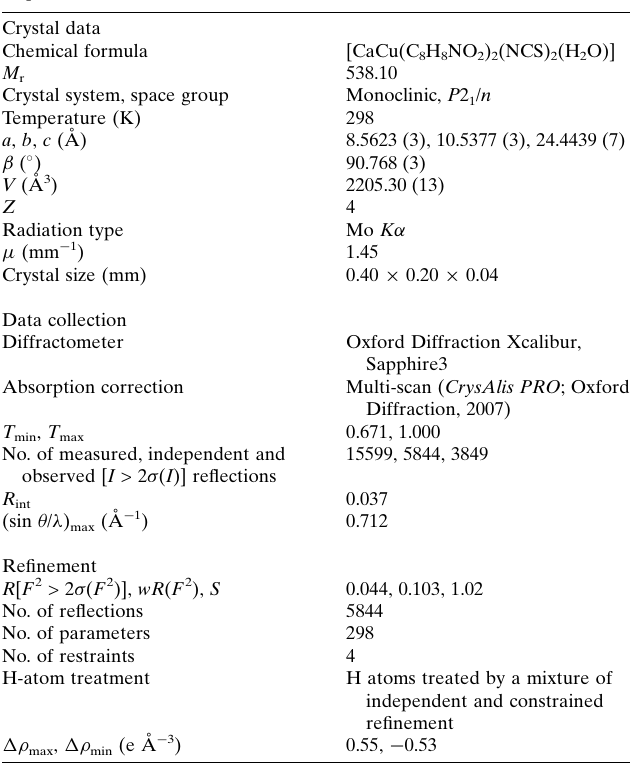
Table 2 Experimental details. Crystal data Chemical